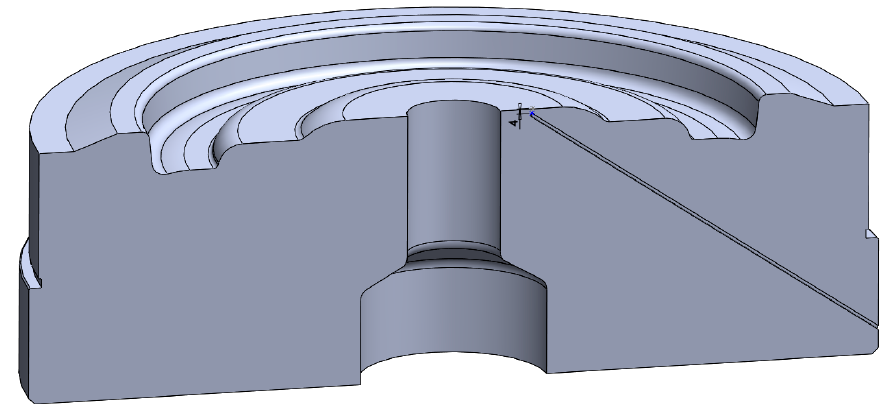
Figure 1. Method of temperature measurement in the tool during die forging.